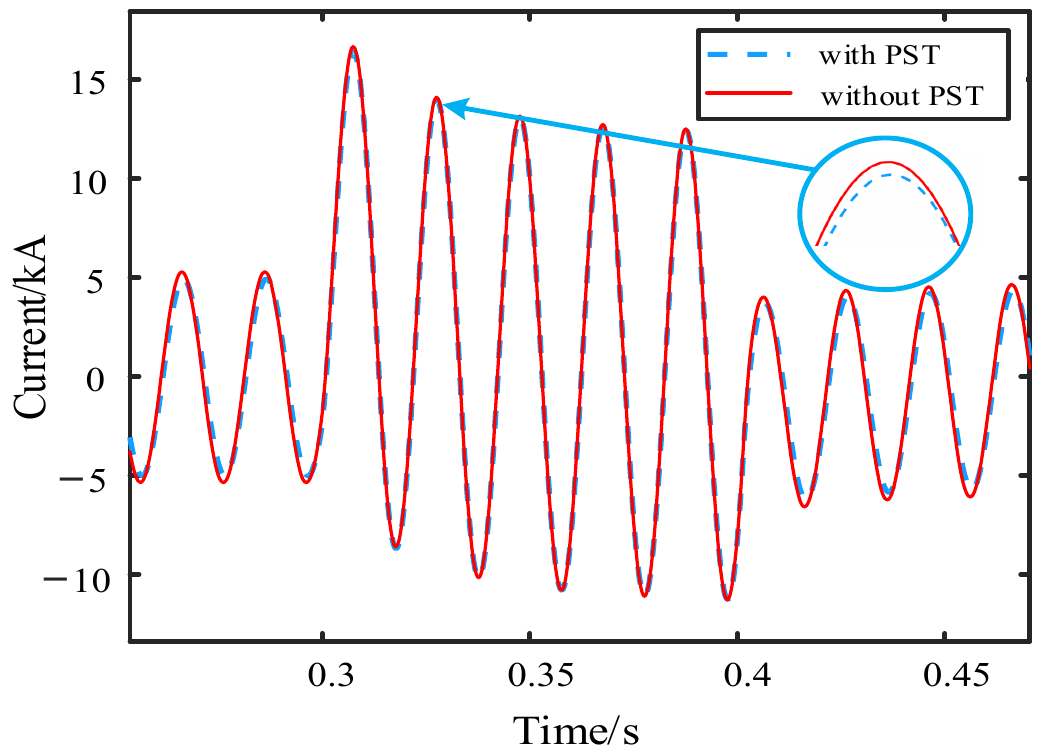
Figure 15. Single phase grounding fault phase